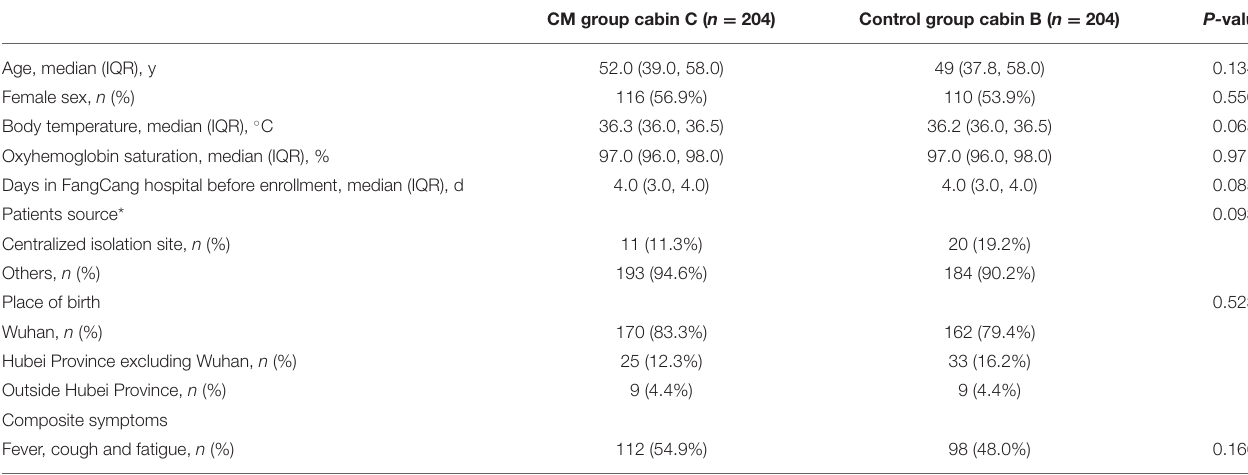
TABLE 2 | Baseline characteristics of patients in the randomly allocated groups.